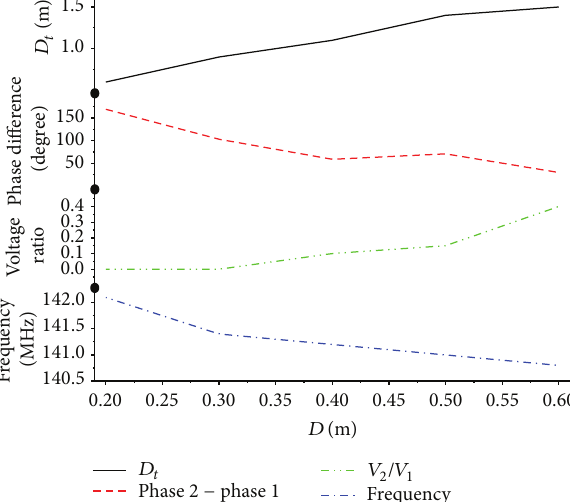
Figure 21: Optimum 𝐷 𝑡 , phase difference, voltage ratio, and fre- quency of case 3 for maximum efficiency PTE mat against separation 𝐷